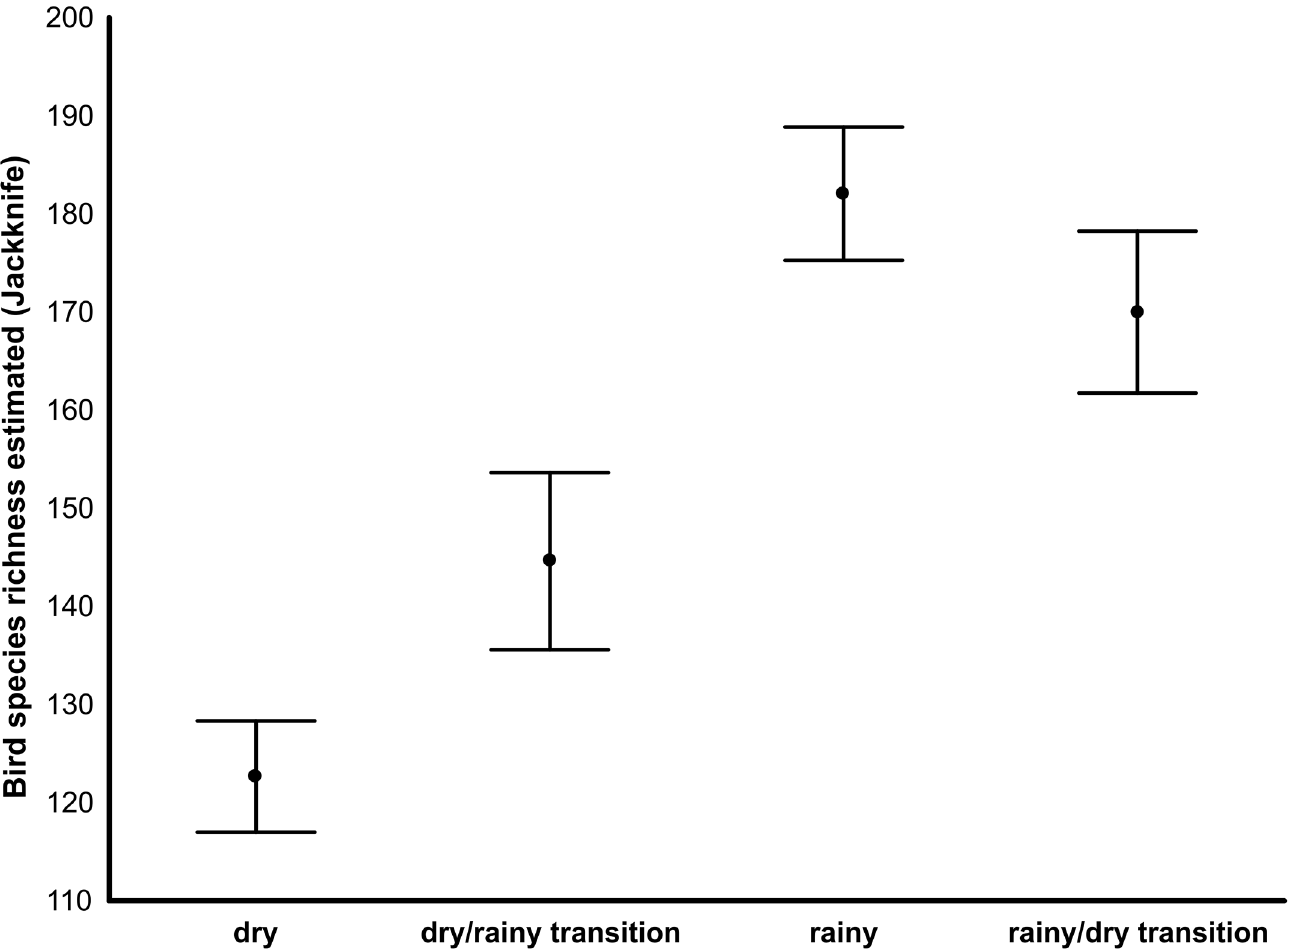
Fig 2. Bird species richness estimated by the 1st order Jackknife estimator in each hydrocycle. The survey was carried out in two areas of Caatinga,namely the Serra da Capivaraand Serra das Confus õ es NationalParks, state of Piauı´, from 2012 to 2013. Error bars represent the 95% confidenceinterval of the